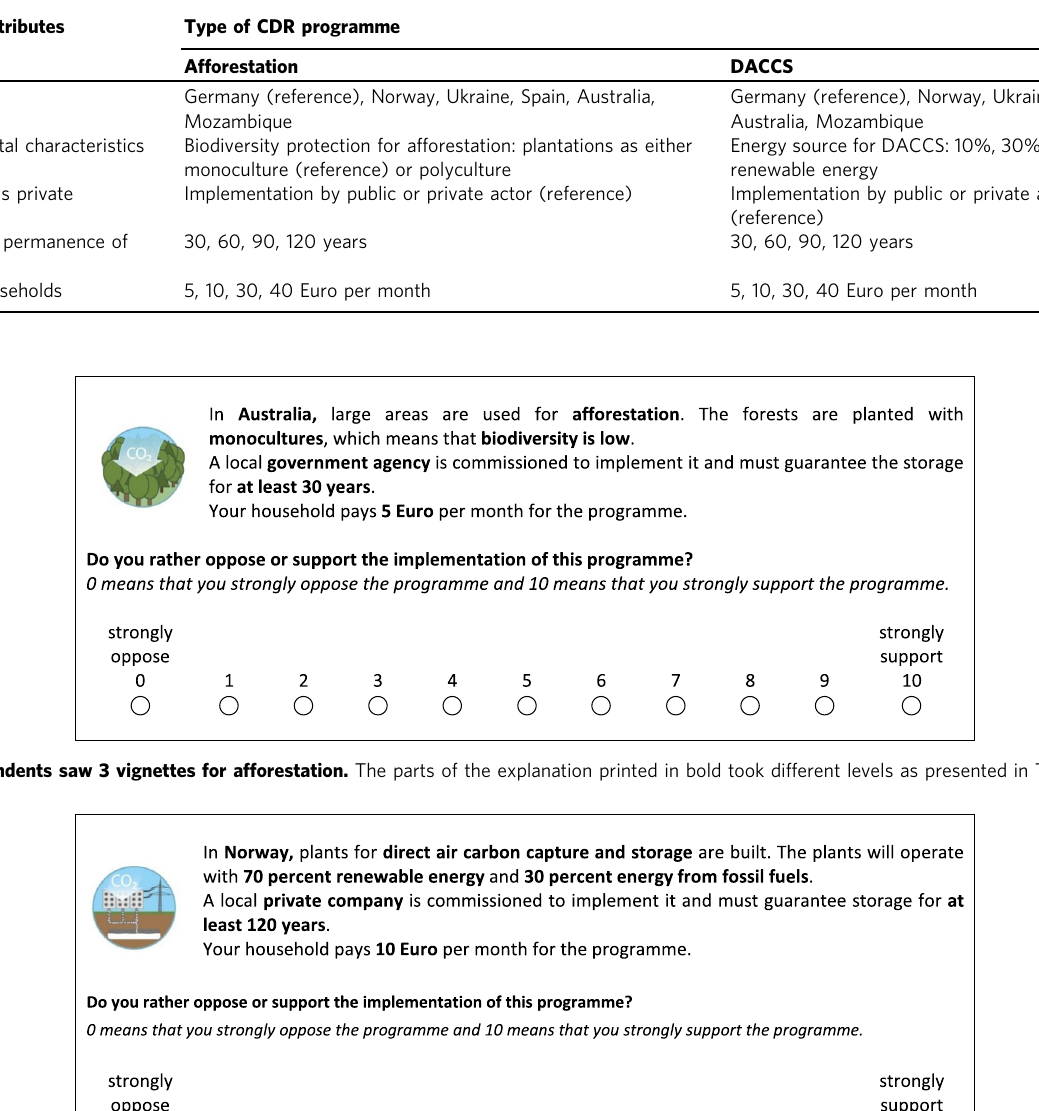
Table 1 Attributes of afforestation and DACCS programmes included in the vignette experiment.